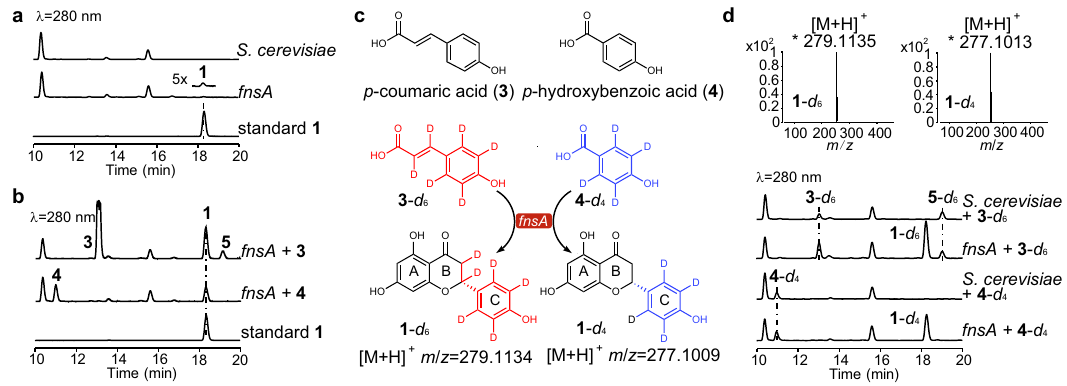
Fig. 2 | Feeding study in S. cerevisiae strain carrying fnsA . a HPLC analysis of secondary metabolites of S. cerevisiae and the transformant containing fnsA . b HPLC analysis of secondary metabolites of S. cerevisiae containing fnsA after feeding experiment. c Structures of the precursors 3 and 4 and the proposed